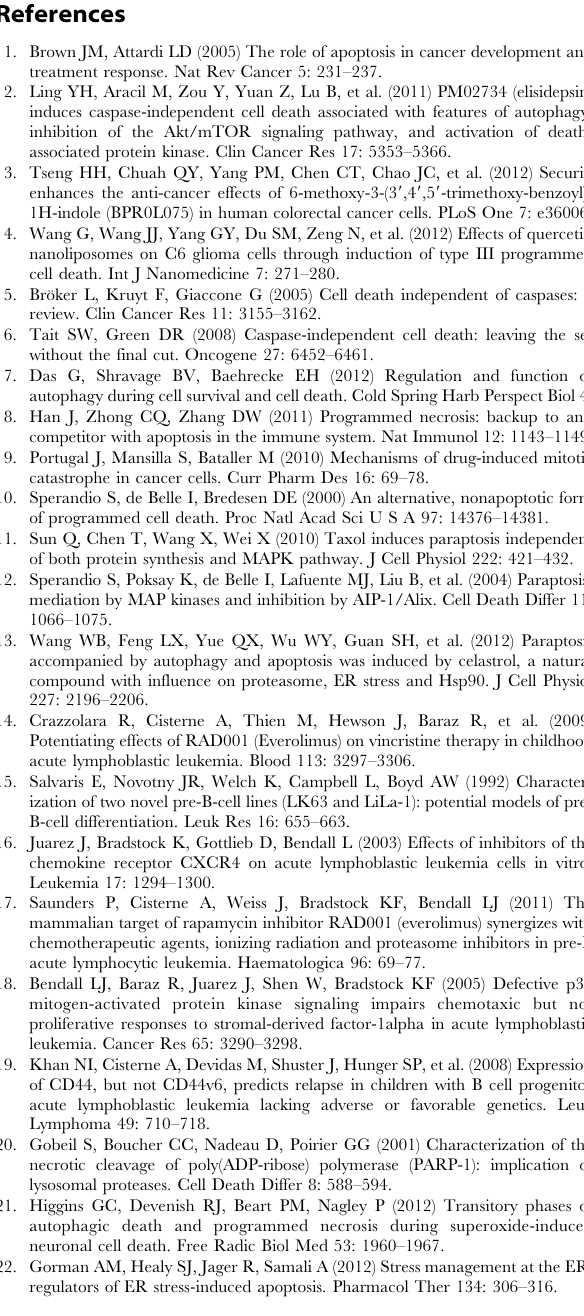
Figure S5 The JNK inhibitor SP600125 (JNKi) blocks everolimus driven phosphorylation of c-jun. Figure S6 Macrophage infiltration of bone marrow following everolimus treatment. Table S1 Details of Patient Samples. Table S2 Primers for qRT-PCR. Table S3 DAVID Analysis of Function by